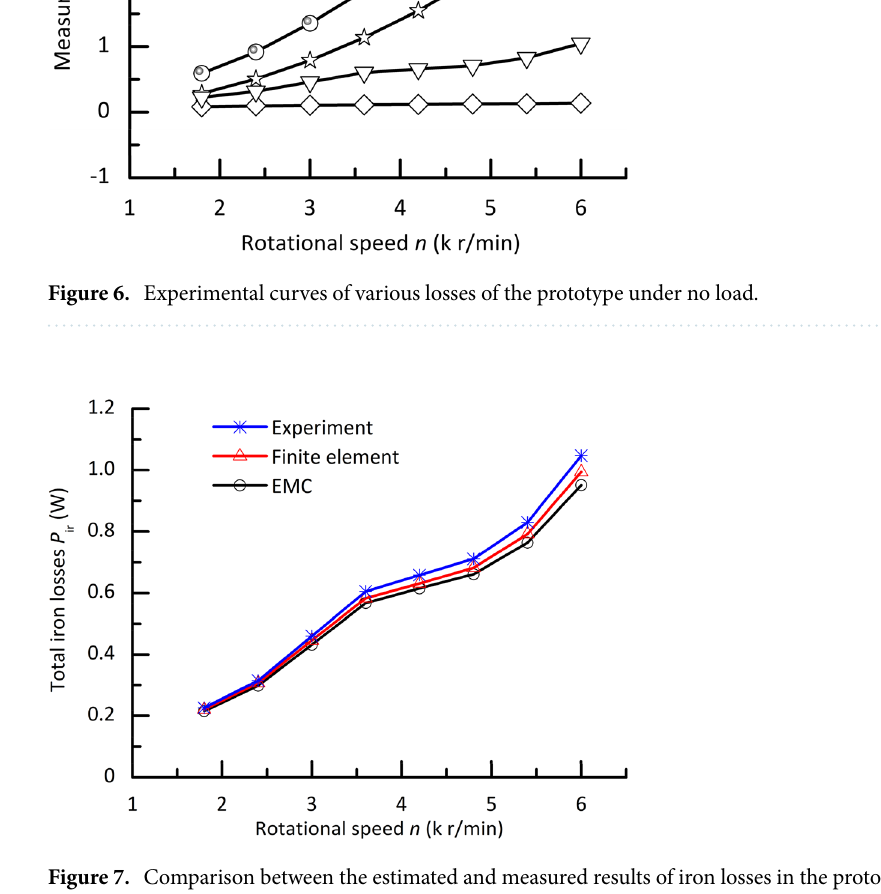
Figure 7. Comparison between the estimated and measured results of iron losses in the prototype at no